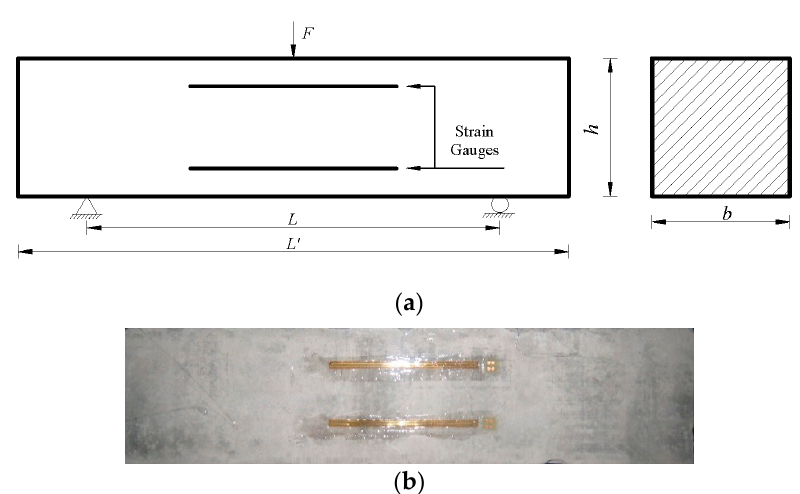
Figure 1. The three-point bending test ( L = 300 mm, L ’ = 400 mm, h = 100 mm and b = 100 mm). ( a ) Profile and ( b ) specimen. F is the applied vertical loading, and L is the distance between the two supports.